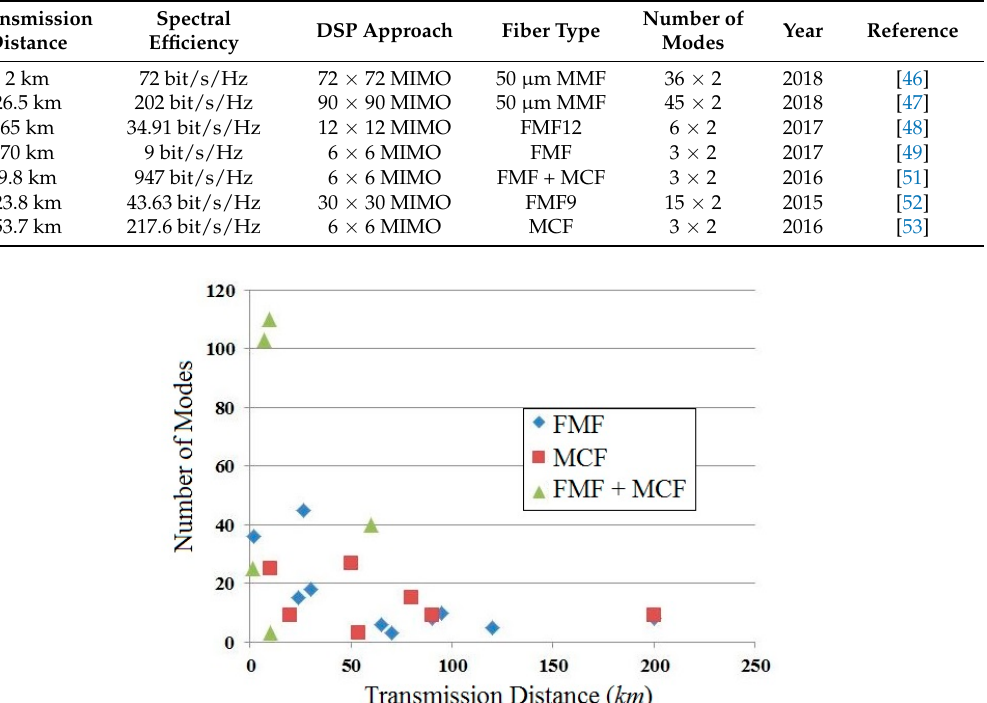
Figure 38. Updated graph of mode numbers vs. the transmission distance in the state-of-the-art SDM-WDM experiments.